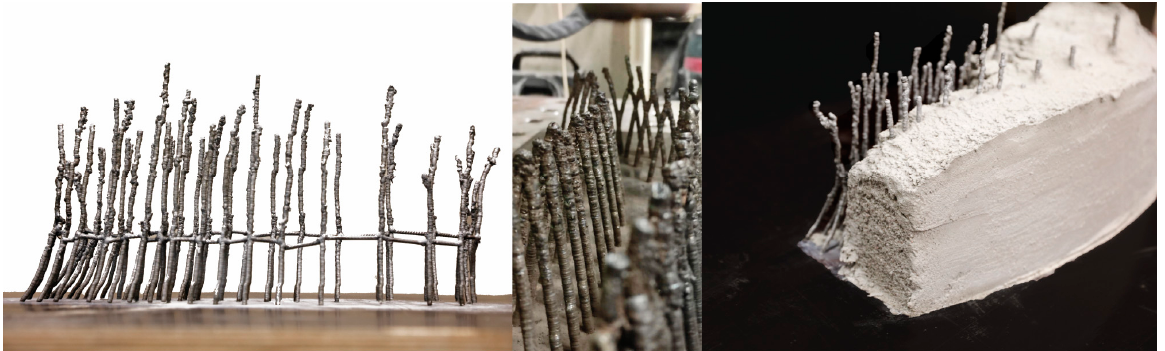
Figure 8. Final SC3DP specimen with integrated force flow compliant WAAM reinforcement struc-